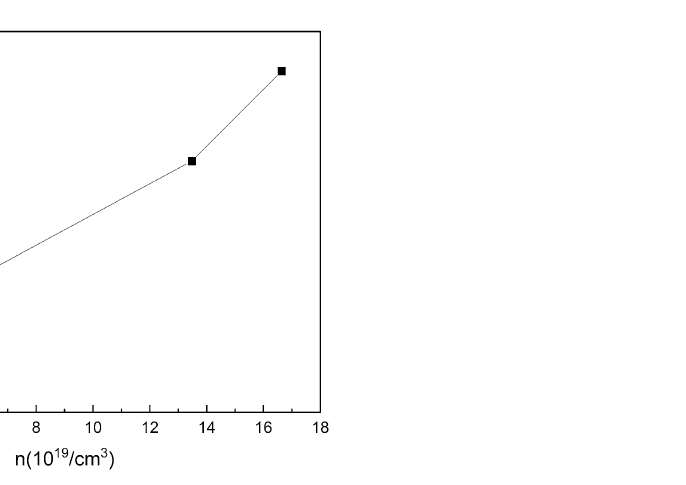
dependence of the Hall resistivity (ρ hall ) at 2 K; ( d ) Hall coefficient (R H ), Carrier concentration (n) and Phase transition temperature (T AFD ) of various Nb doped SrTiO 3 single crystals at 2 K.